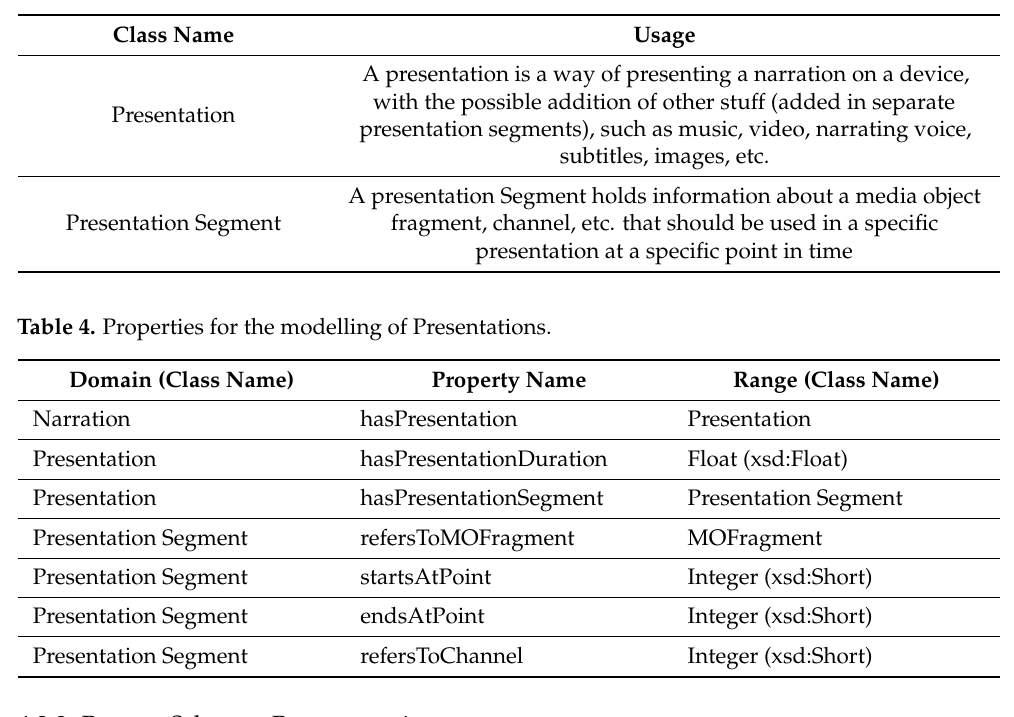
Table 3. Classes for the modeling of Presentations.